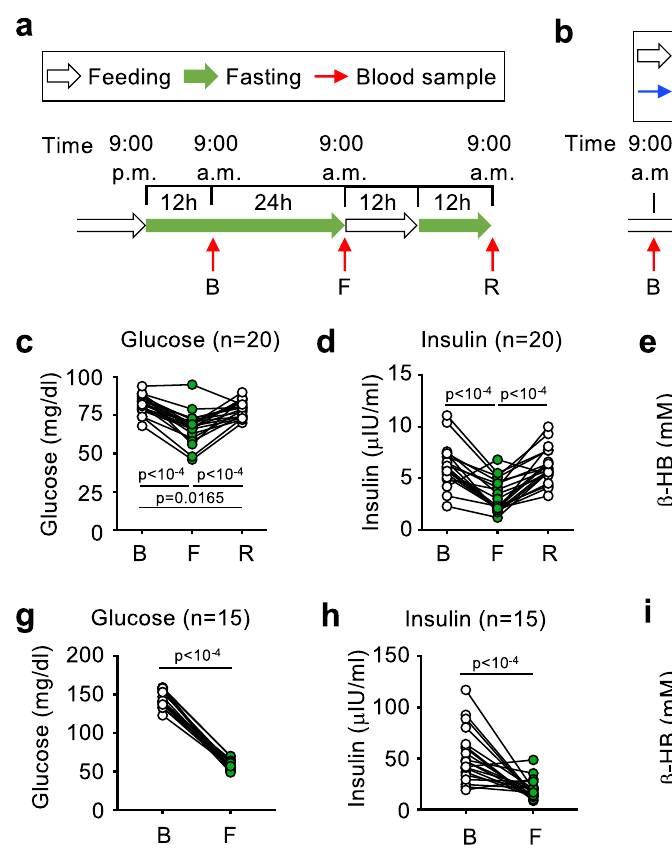
Fig.1|Standardbiomarkersofshort-termfastinginhealthyhumansandmice. a , b Scheme of the protocols followed for the short-term fasting experiment in humans ( a ) and mice ( b ). Green arrows indicate the times of fasting, and white arrows indicate normal feeding. Red arrows indicate blood sampling; blue arrows indicate chemotherapy administration, and black arrows indicate sacri fi ce. c – f Blood levels in human volunteers of glucose ( c ), insulin ( d ), β -hydroxybutyrate ( β - HB, e ) and free fatty acids (FFAs, f ) atthe basalpoint after 12h of overnight fasting (B);after36hoffasting(F);andafter12hofrefeedingand12hofovernightfasting